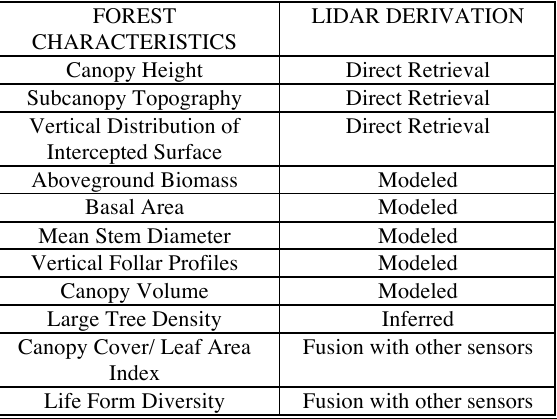
Table 1: Potential Contributions of LiDAR Remote Sensing in Forestry Application (Dubayah, no